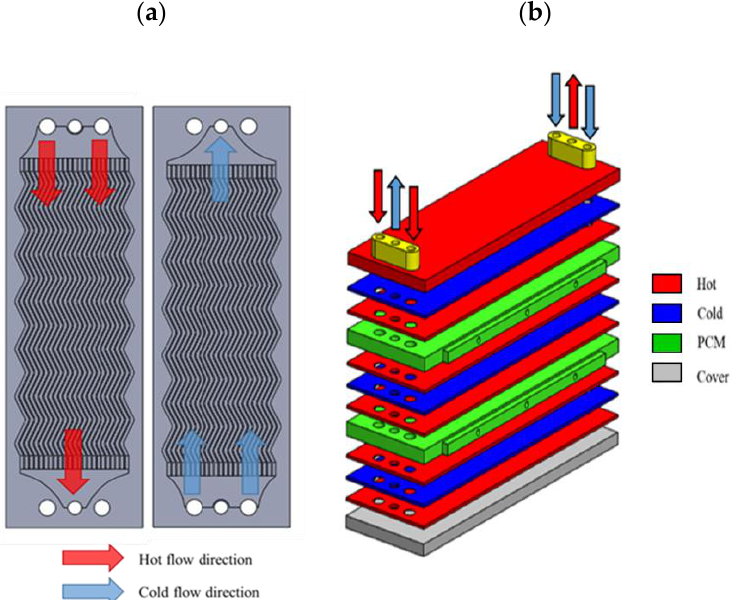
Figure 2. ( a ) The directions of cold/hot water flows in the flow channel plates, and ( b ) the structure of the PHE.